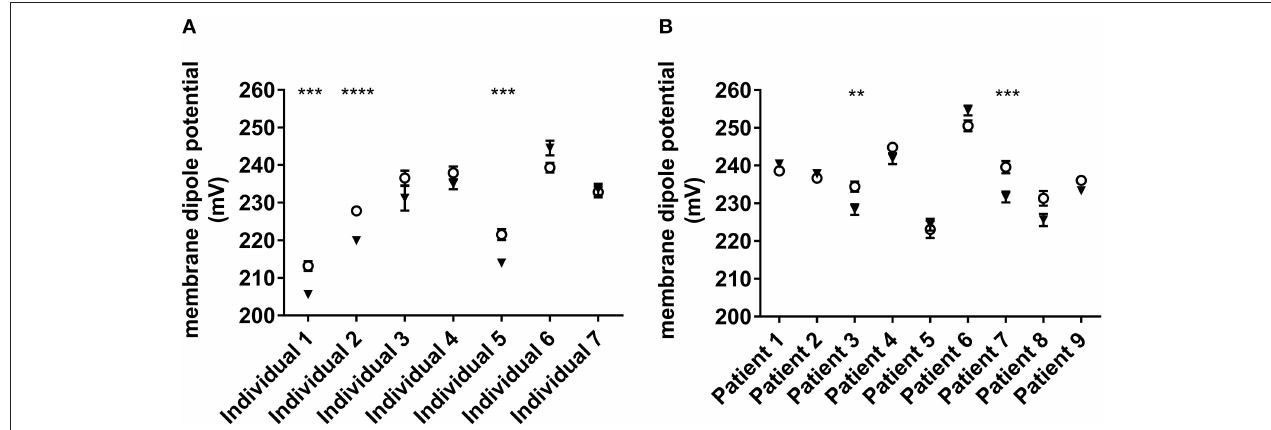
FIGURE 1 | CAT-8015-induced changes in the MDP of RBCs. (A) Effect of CAT-8015 on the MDP of RBCs from healthy individuals ( n = 7). (B) Effect of CAT-8015 on the MDP of RBCs from ALL patients ( n = 9). Control ( ◦ ); CAT-8015 ( H ). Significant differences are indicated (** P < 0.01, *** P < 0.001, **** P < 0.0001). Statistical significance was determined using Holm-Sidak method, with alpha = 0.05, multiple t -tests, one unpaired t -test per row. At least 50 cells per treatment were analyzed.